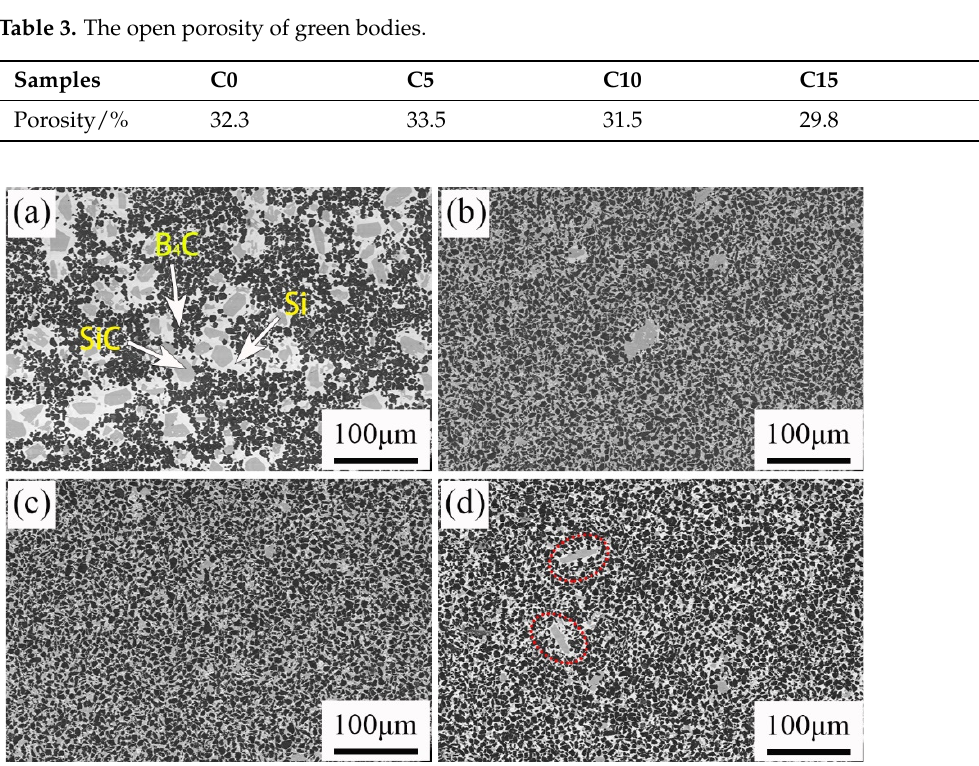
Table 3. The open porosity of green